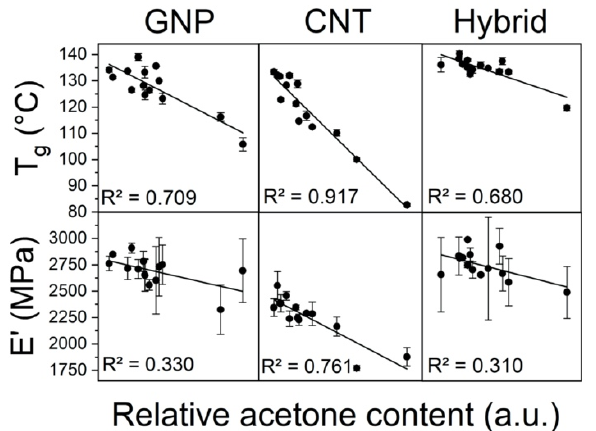
Figure 12. Dependence of T g and E’ on residual acetone content. Straight lines represent linear fitting of the data.